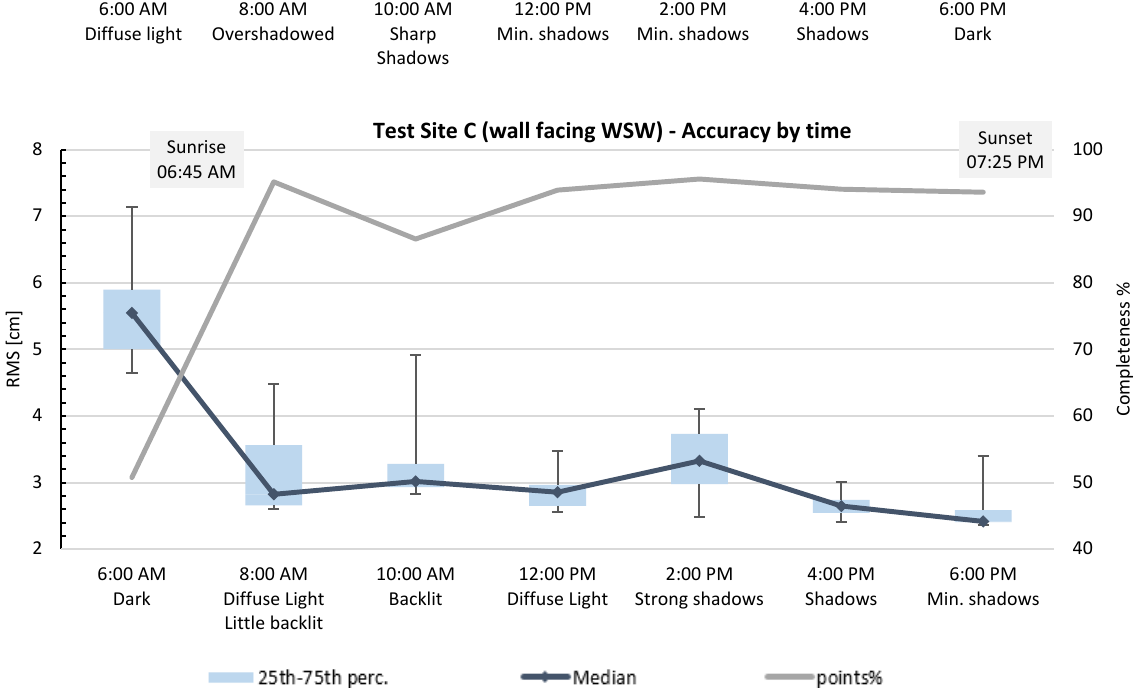
Figure 4. RMS and completeness variability for a) test site A, b) test site B and c) test site